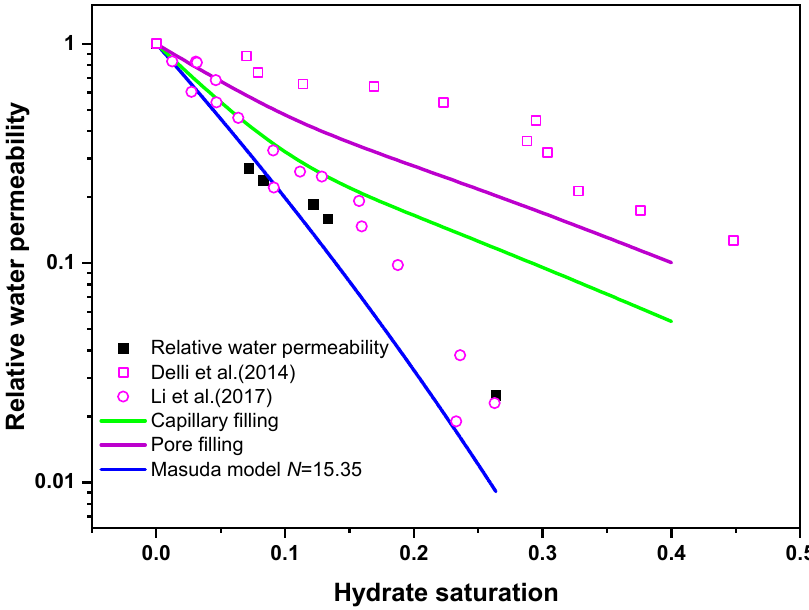
Figure 6. Comparison of experimental data with theoretical permeability models.